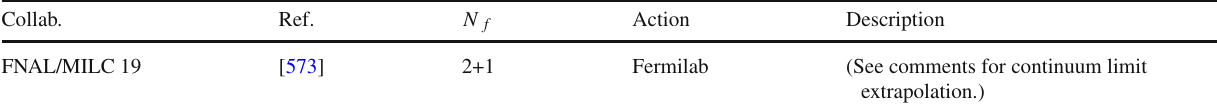
Table 159 Heavy-quark treatment in determinations of B → π(cid:6)ν , B s → K (cid:6)ν , and (cid:8) b → p (cid:6) ¯ ν form factors Collab.